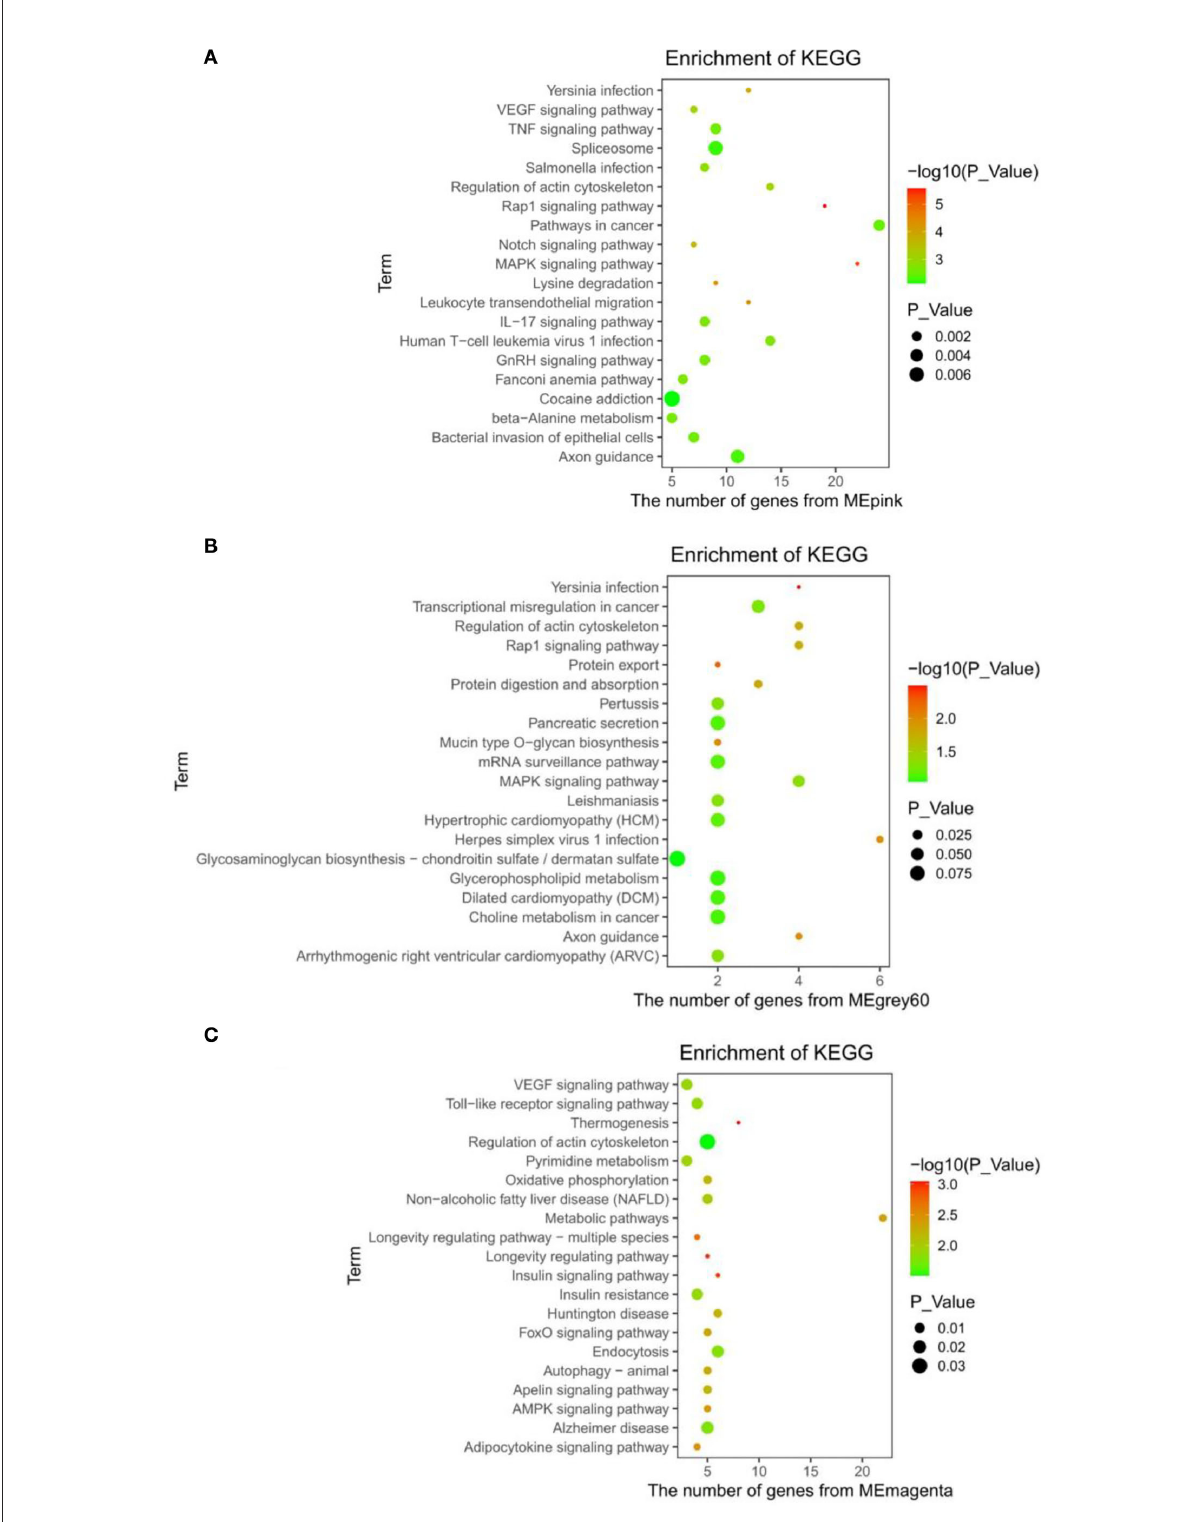
FIGURE4 KEGG enrichment results. (A) Pink module. (B) Grey60 module. (C) Magenta